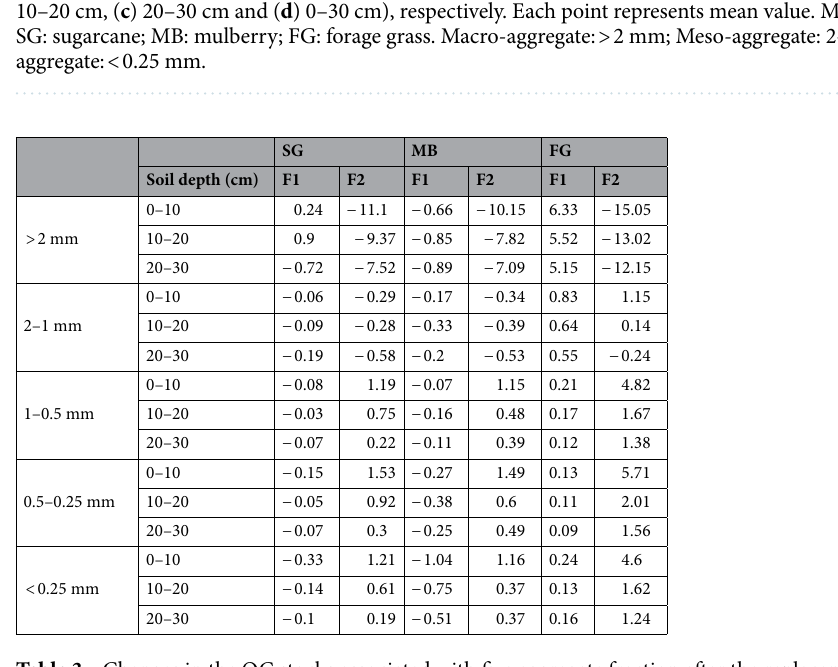
Table 3. Changes in the OC stocks associated with five aggregate fraction after the replacement of MS to SG, MB and FG. F1 present the change in OC stock attributed to changes in the OC content associated-aggregate following cropland conversion. F2 present the change in OC stock attributed to changes in the mass of aggregate fraction after conversion. SG: sugarcane; MB: mulberry; FG: forage grass.